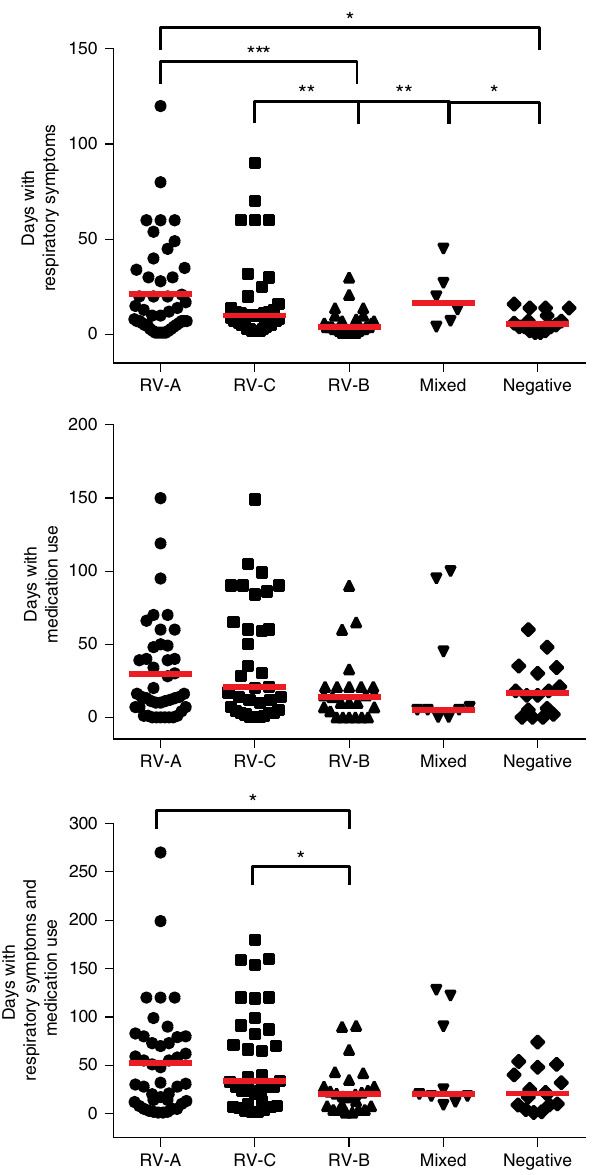
Fig. 4 Days with respiratory symptoms and medication use in children without and with RV-A, RV-B, RV-C, or mixed peptide-speci fi c IgG increases. Days with respiratory symptoms (top panel, y -axis), with medication use (middle panel, y -axis), and with symptoms and medication use (bottom panel, y -axis) are shown for children without (negative), mixed, RV-A, RV-C, or RV-B increases of IgG ( x -axes). Horizontal lines show median values. Statistically signi fi cant differences between groups are indicated (*** p < 0.001; ** p < 0.01, * p < 0.05) (Mann – Whitney U